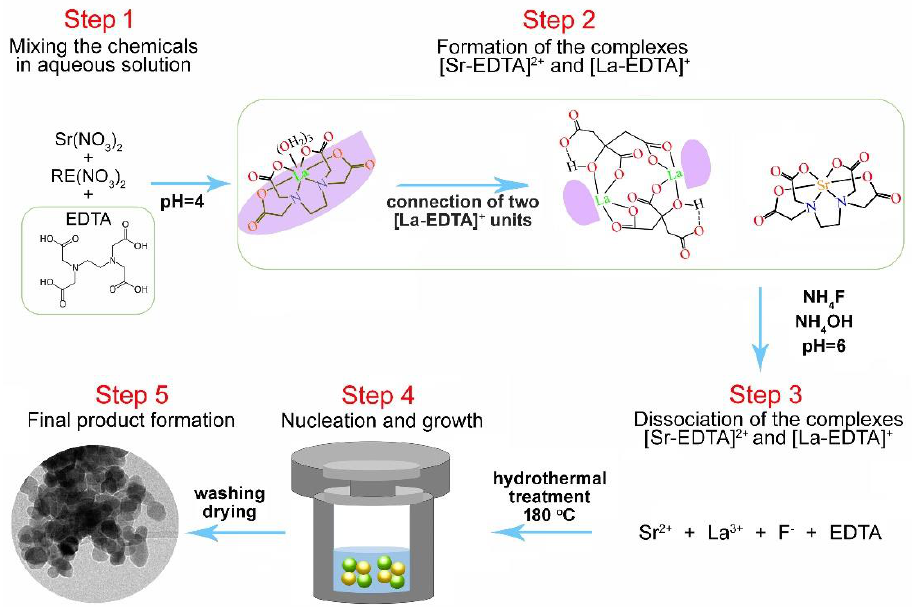
Figure 1. Synthesis of SLF:Yb,Tm nanophosphors using a simple EDTA-assisted hydrothermal method.